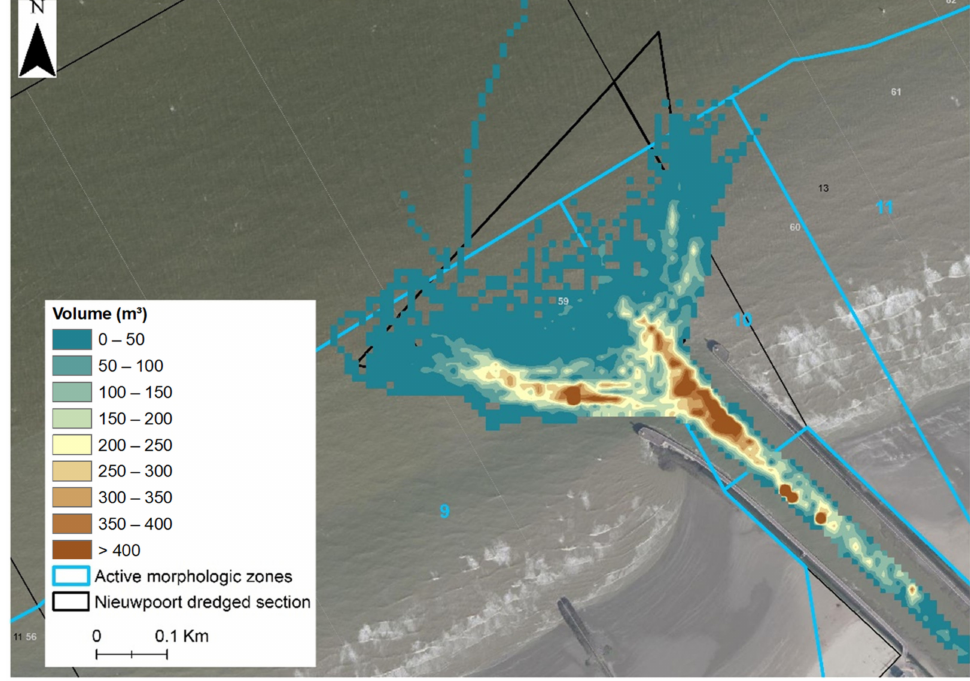
Figure 7. Dredging intensity maps based on dredging data from the period 2016–2020.